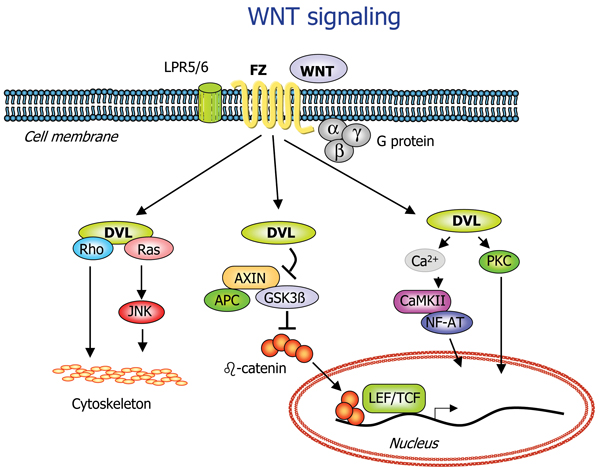
WNT Pathways. The extracellular signaling molecule WNT activates three pathways: (1) Early cell fate decisions are controlled via the canonical pathway (middle): it comprises the regulation of gene expression by inducing β-catenin-mediated transcriptional activation. Interaction of WNT with the transmembrane receptor frizzled (FZ) activates dishevelled (DVL), which induces the disassembly of a complex consisting of axin, adenomatosis polysis coli (APC), glycogen synthase kinase 3β (GSK3β) and β-catenin. In non-stimulated cells, GSK3β phosphorylates β-catenin, thereby triggering its degradation. Activitation of the pathway effectively increases the levels of β-catenin in the cyctoplasm, which is then translocated to the nucleus. Here it it forms the β-catenin-T-cell specific transcription factor complex that activates the transcription of target genes. (2) In the planar cell polarity pathway (left), FZ functions through G-proteins to activate DVL, which thereupon signals to Rho GTPases (Rho or Rac or both). Activated Ras signals through the c-Jun amino (N)-terminal kinase (JNK). Activation of Rho-GTPases induces changes in the cytoskeleton. In neurons, this pathway is involved in dendritic arborization. (3) In the WNT/calcium pathway (right), activation of DVL activates protein kinase C (PKC) and induces the release of intracellular calcium, which activates a calcium/calmodulin-dependent protein kinase II (CaMKII).